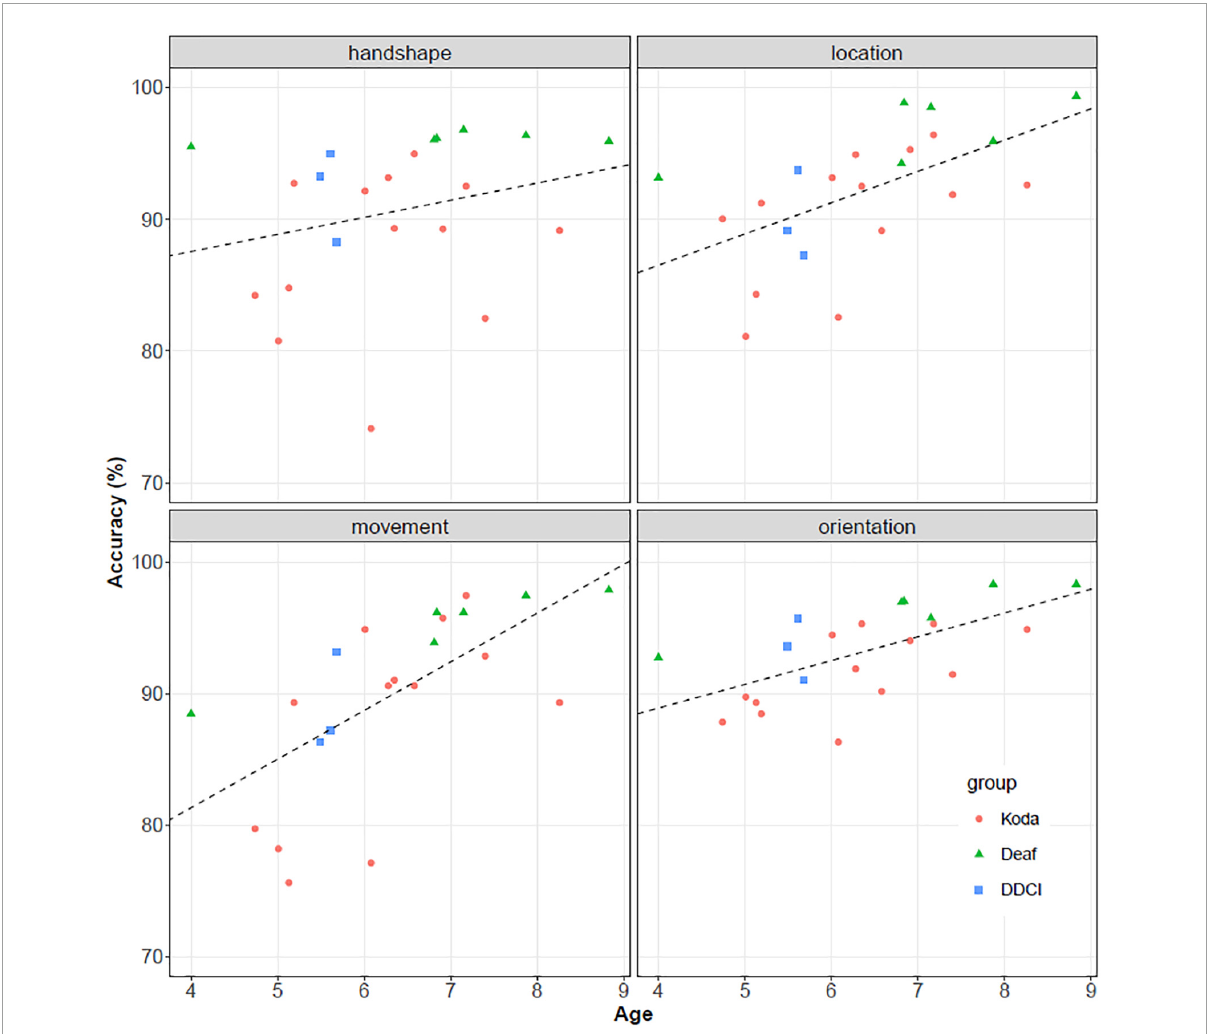
FIGURE7 Individual parameter accuracies and their relationships to